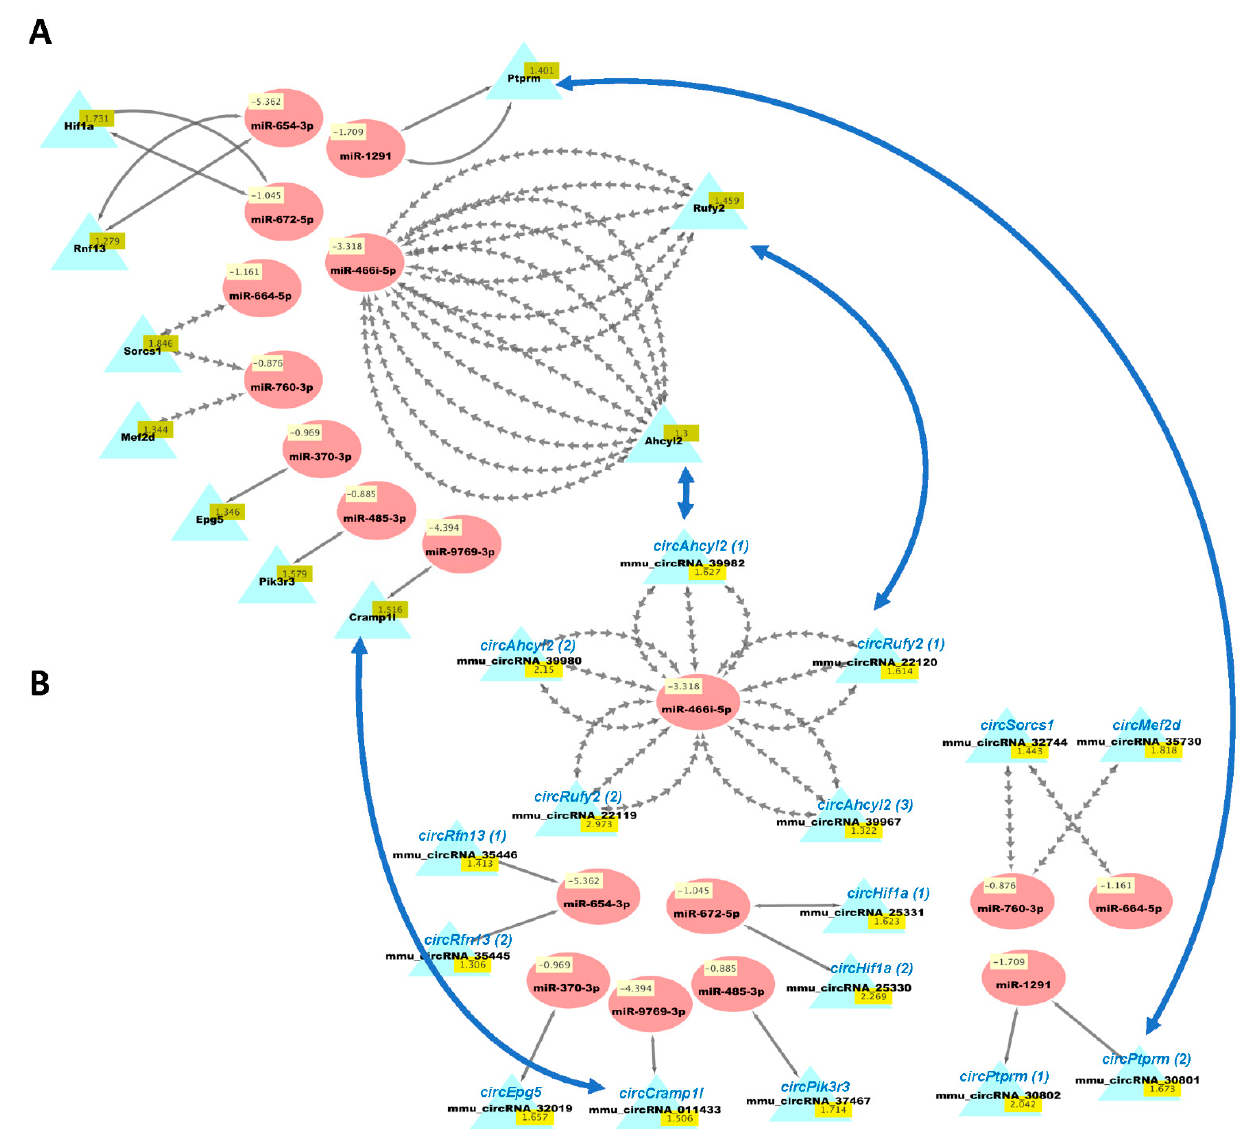
Figure 6. Cytoscape visualizations of predicted ceRNA interactions between significantly downregulated miRNAs in HuD KO striatum and significantly upregulated mRNAs ( A ) and circRNAs ( B ) derived from the same genes . Panels show that the mRNAs and circRNAs from same set of genes contain MRE sequences that are predicted to interact with a set of nine downregulated miRNAs (see Table S7). The names of the circRNAs are based on the genes they are derived from and are shown for comparison with the mRNAs; the numbers after the names indicate different circRNAs derived from the same gene. Multiple gray arrows indicate multiple predicted interactions and a single gray line, a single interaction. Blue arrows show examples of the potential competition of mRNAs and circRNAs for binding to and being regulated by the same miRNAs.